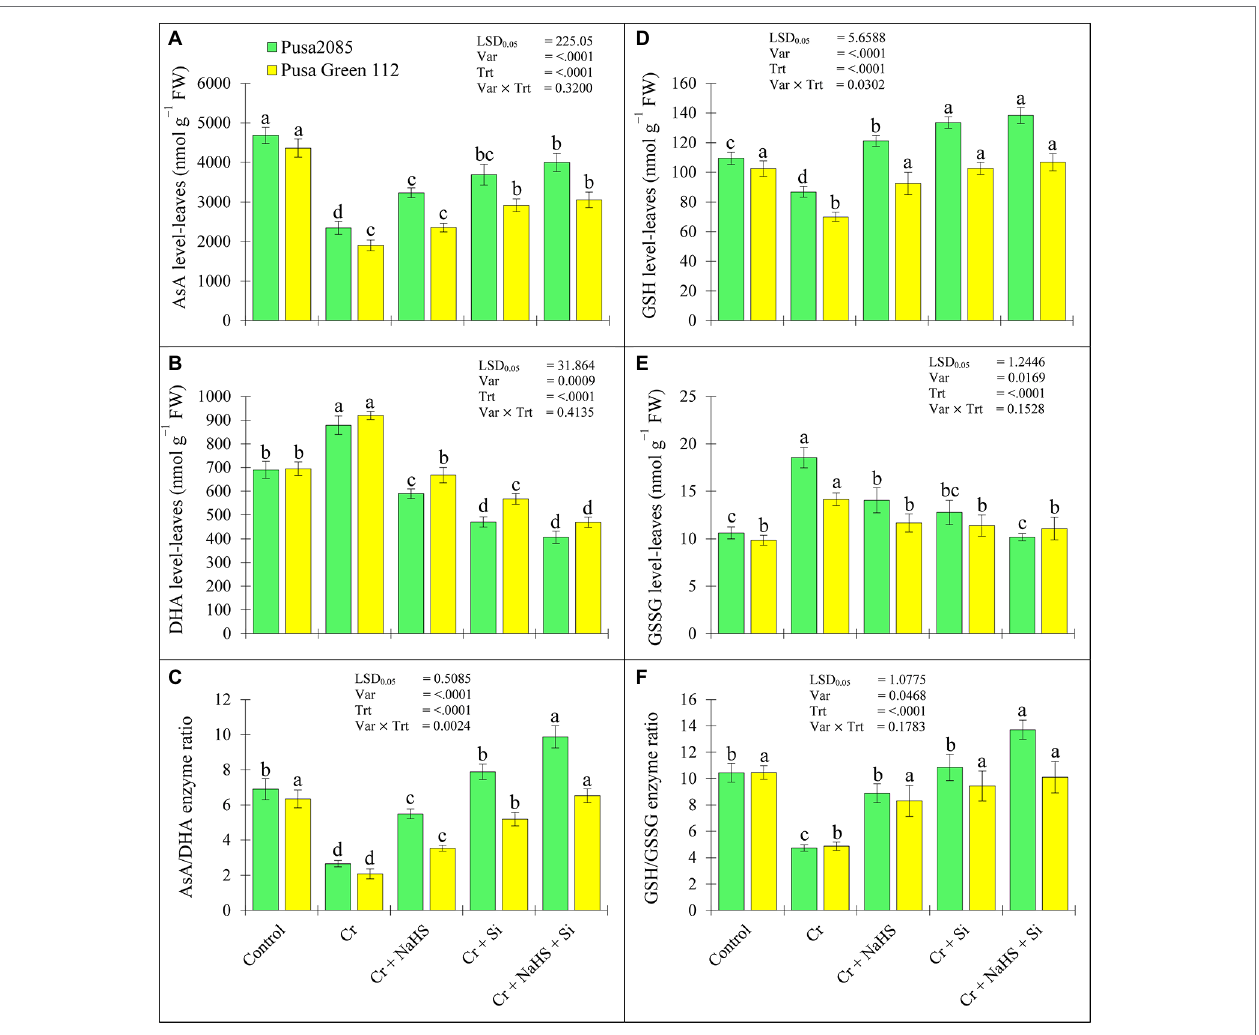
FIGURE 5 | Effect of NaHS, Si, and NaHS+Si treatments non-enzymatic activities of (A) AsA-ascorbic acid, (B) DHA-dehydroascorbic acid, (C) AsA/DHA enzyme ratio, (D) GSH-glutathione, (E) GSSG-oxidized glutathione, and (F) GSH/GSSG enzyme ratio in leaves of both chickpea plants grown during Cr VI stress. Data are presented as mean ± SE ( n = 5) and different bar letters are indicated statistically differences ( p < 0.05) as tested by the least significant difference